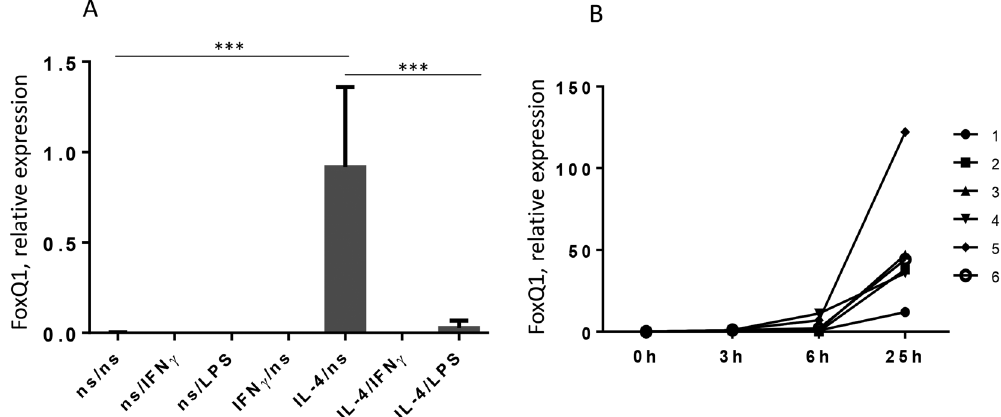
Figure 1. The analysis of FoxQ1 mRNA expression in primary human macrophages. ( A ) Macrophages of 8 healthy donors were stimulated with IL-4 or left non-stimulated (ns) for 6 days and then re-stimulated with IFN- γ or LPS for 6 hours. FoxQ1 expression was assessed using RT-qPCR. The data are mean ± SD. *** p < 0.001, one-way ANOVA with Tukey’s multiple comparison test. ( B ) The dynamics of FoxQ1 mRNA expression was studied in IL-4-stimulated monocytes isolated from 6 healthy donors using